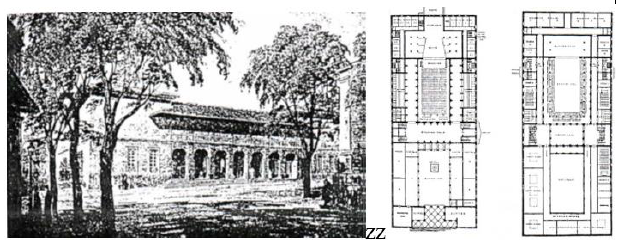
Figure 1. First Prize for House of German-Turkish Friendship